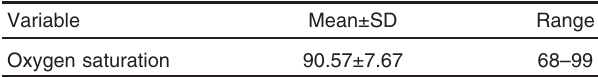
Table 3 Oxygen saturation among the studied patients